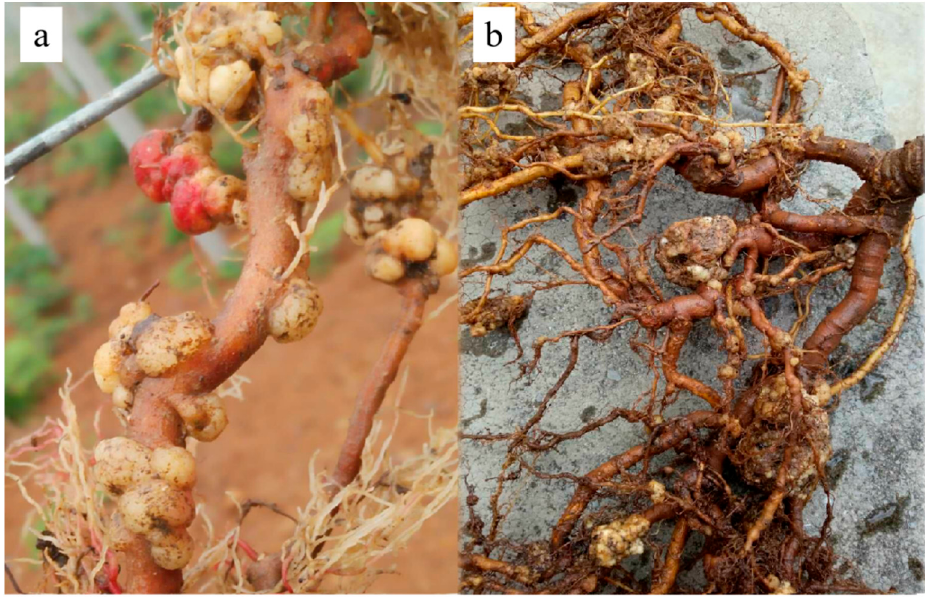
Figure 1. Crown gall disease in a kiwifruit plant root caused by A. fabacearum in the field. ( a ) Early stage of onset; ( b ) later stage of onset.